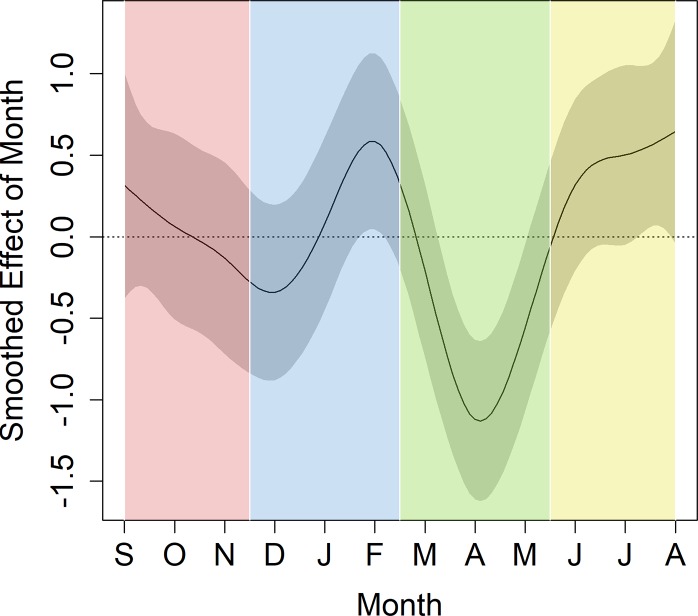
Smoothed effect of month on the amount of touchscreen activity for all females.Gray bands represent 95% confidence intervals for the fitted smooth effect. Areas where the gray bands do not overlap with the central y = 0 line reflect areas of significant seasonal effect. The x-axis is scaled in months, beginning in September and ending in August. The colored vertical bands represent the different seasons.